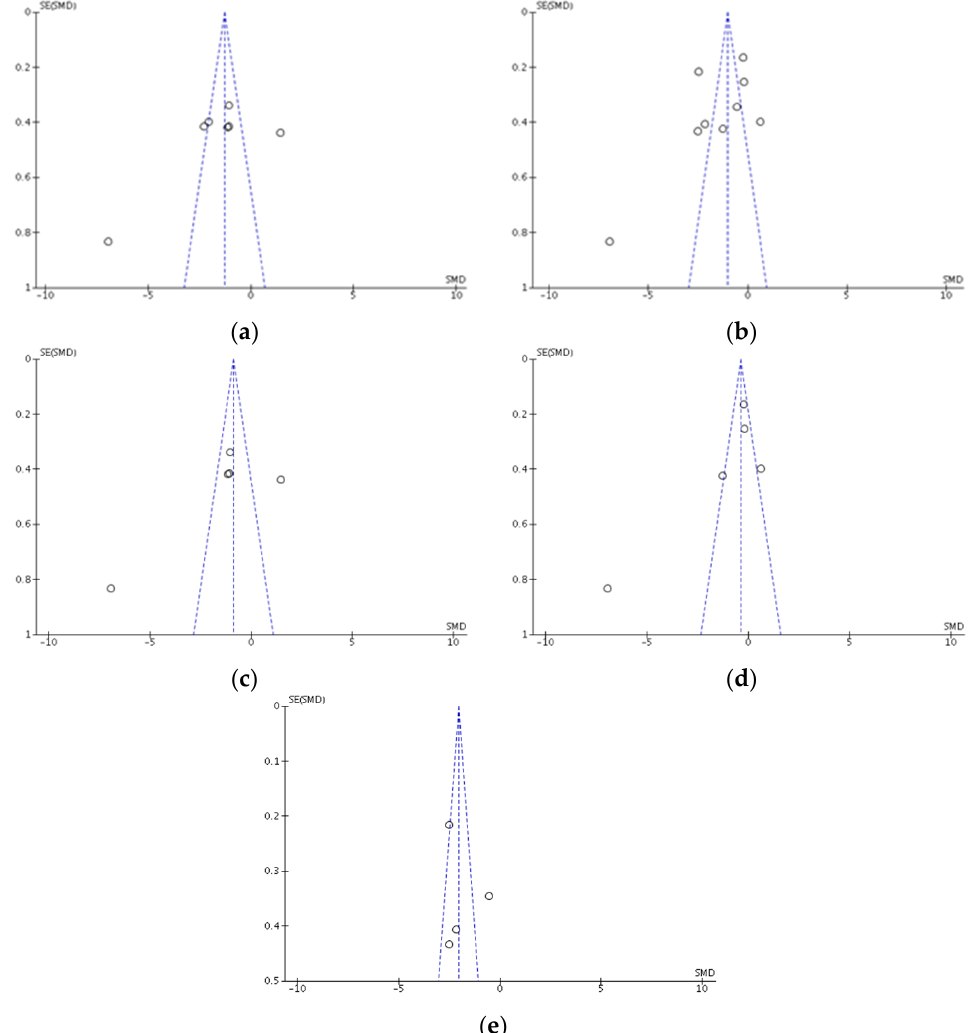
Figure 2. The standard error in different modes of strength intervention for anxiety and depression. ( a ) strength training and concurrent training for anxiety; ( b ) strength training and concurrent training for depression; ( c ) concurrent training for anxiety; ( d ) concurrent training for depression; ( e ) strength training for depression; SE: standard error; SMD: standardized mean difference.